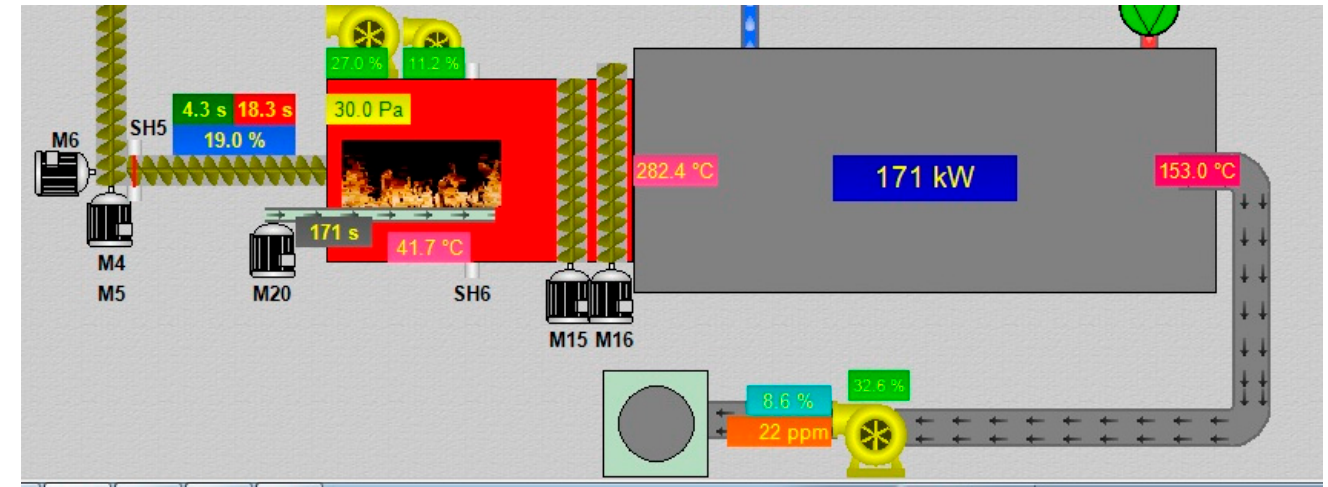
Figure 5. The graphical visualization of the monitored wood chips boiler.